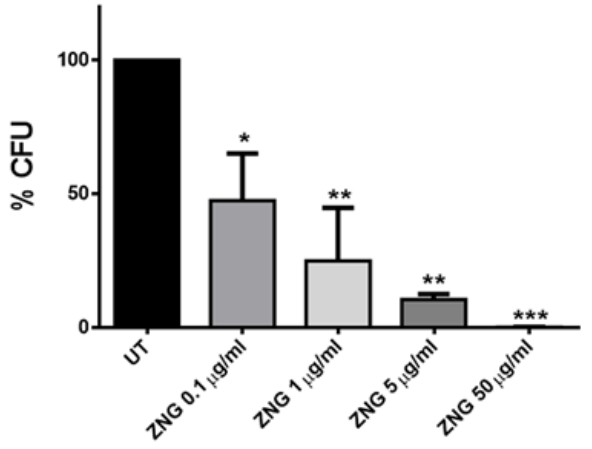
Figure 6. Concentration-dependent antibacterial activity of ZnO-NRs-decorated GNPs (ZNG) against bacteria cells. Loss of cell viability rate was obtained by colony counting method. Error bars represent